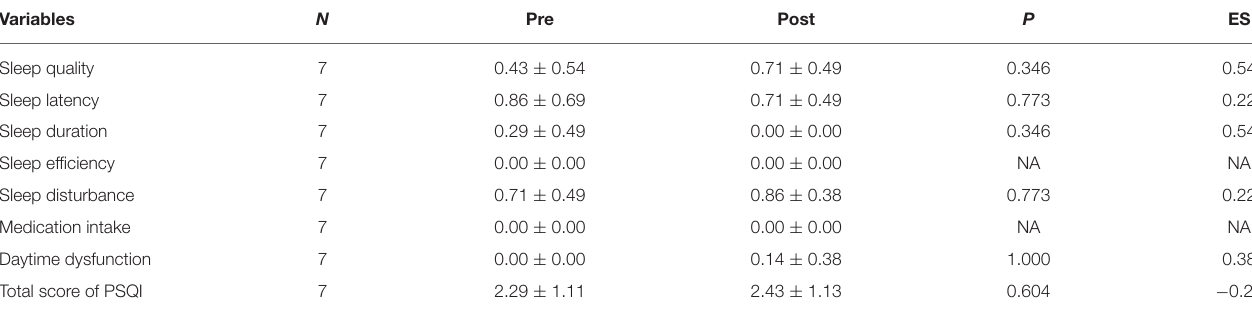
TABLE 4 | Sleep variables before and after the home training